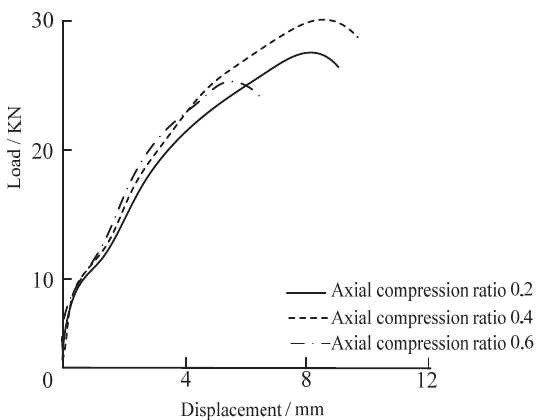
Figure 13: Curves of load-displacement (corrosion rate 5%). Figure 14: Curves of load-displacement (corrosion rate